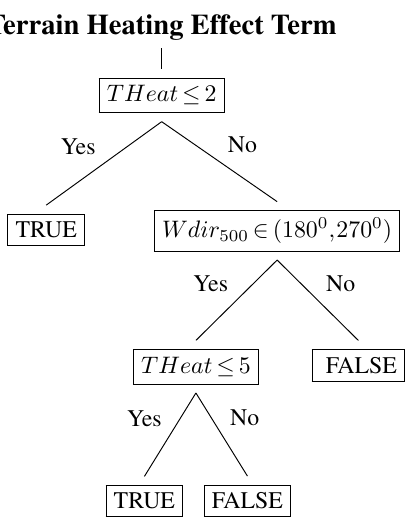
Figure 5. Schematic diagram of the terrain heating effect term. Fig. 5. Schematic diagram of the Terrain Heating Effect Term Fig. 4. Schematic diagram of the Moisture Term